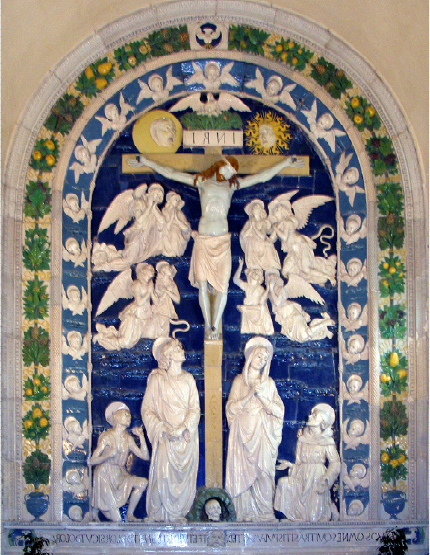
Figure 4. Andrea della Robbia, Crucifixion , enamel terra cotta, Chapel of the Stigmata (photo source: Tetraktys, Public domain, via Wikimedia Commons).